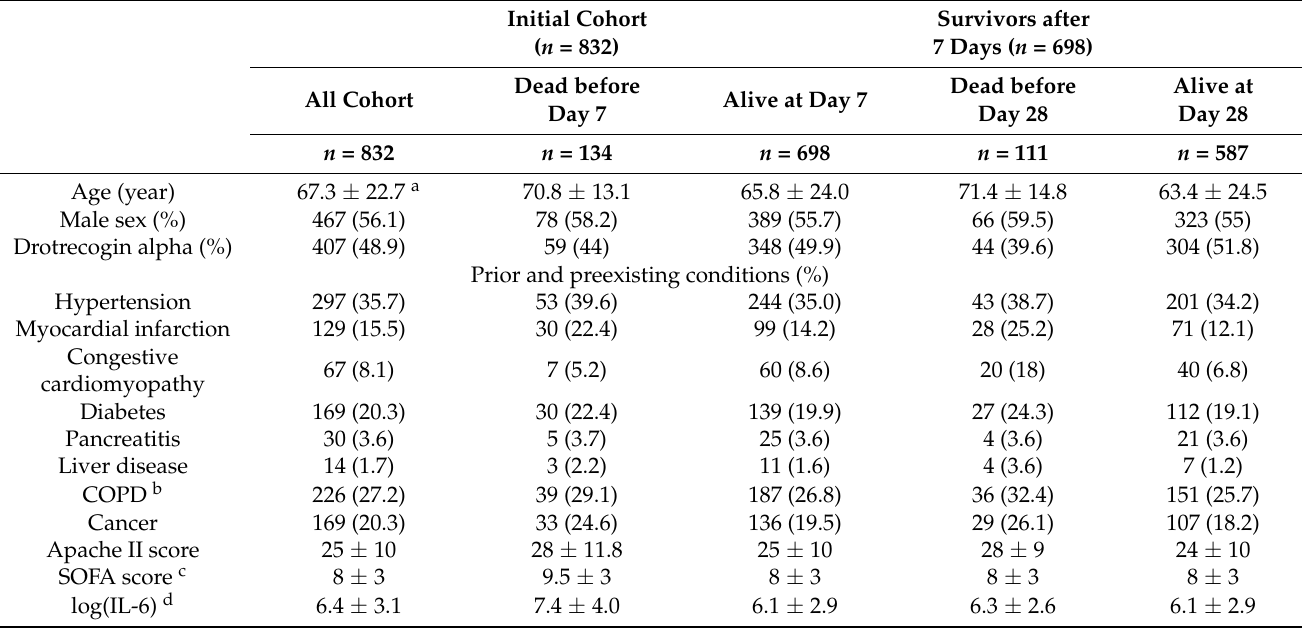
Table 4. Characteristics of